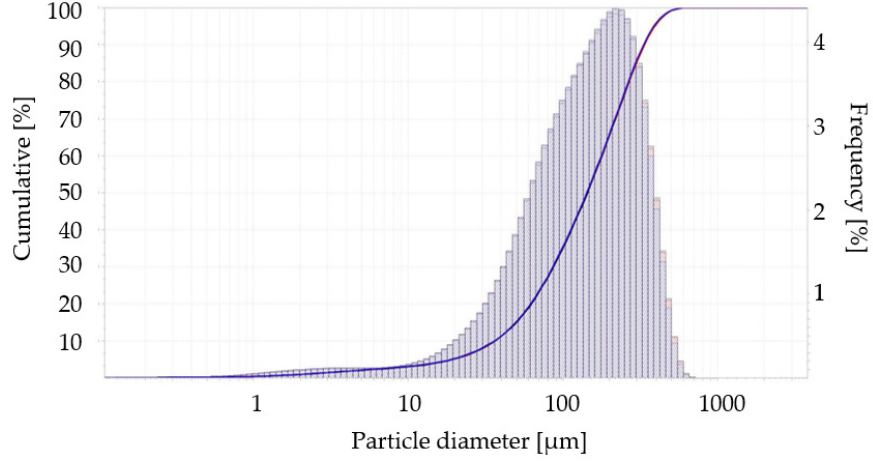
Figure 1. The frequency distribution and cumulative frequency of particle size distribution of sludge dust (measurement 1).